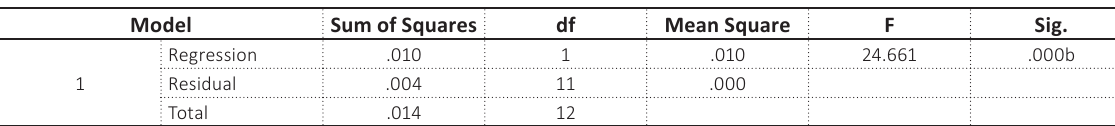
Table 5b. ANOVA result for hypothesis two